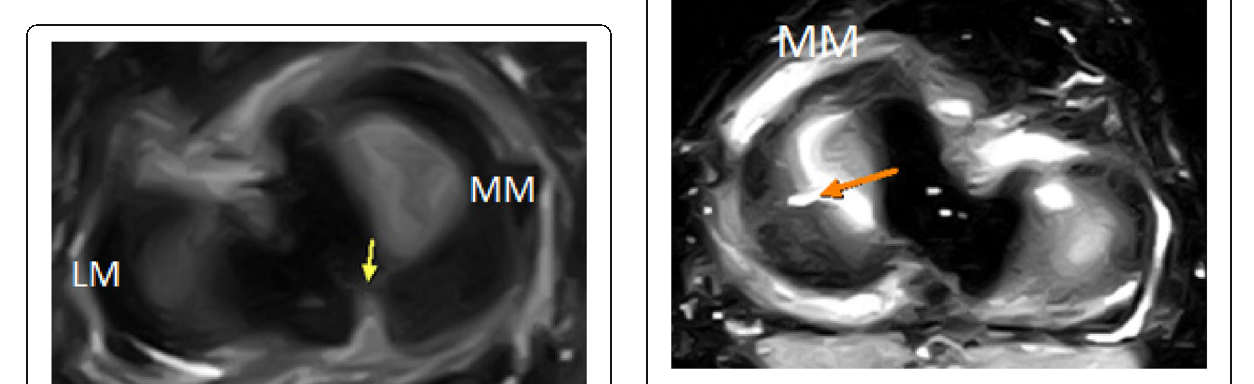
Fig. 4 Thin axial fat-saturated PD WI revealed a small incomplete radial tear related to the body of the medial meniscus (orange arrow) involving the free meniscal edge (sparing the menisco- capsular attachment). MM = medial